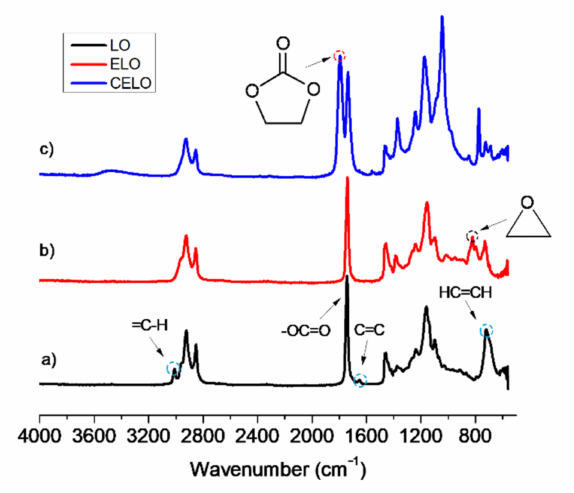
Figure 1. Fourier transform infrared spectroscopy (FT-IR) spectrum of ( a ) linseed oil (LO), ( b ) epoxi- dized linseed oil (ELO), and ( c ) carbonated epoxidized linseed oil